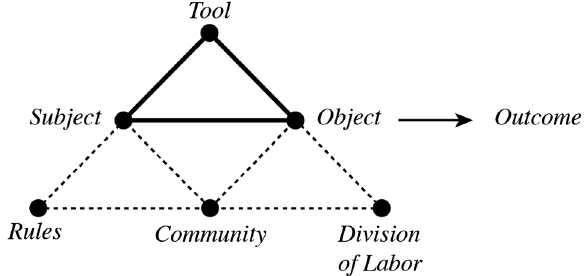
FIG. 1. A representation of the structure of activity, as described by activity theory. The upper (solid) triangle represents the mediated — by a tool — and direct pathways by which a subject interacts with an object, and is the unit of mediated cognition discussed by Vygotsky and others [24,26]. The other nodes in the triangle show the larger activity system, highlighting the con- nections between individual cognition and the larger sociocul- tural history in which the current activity is